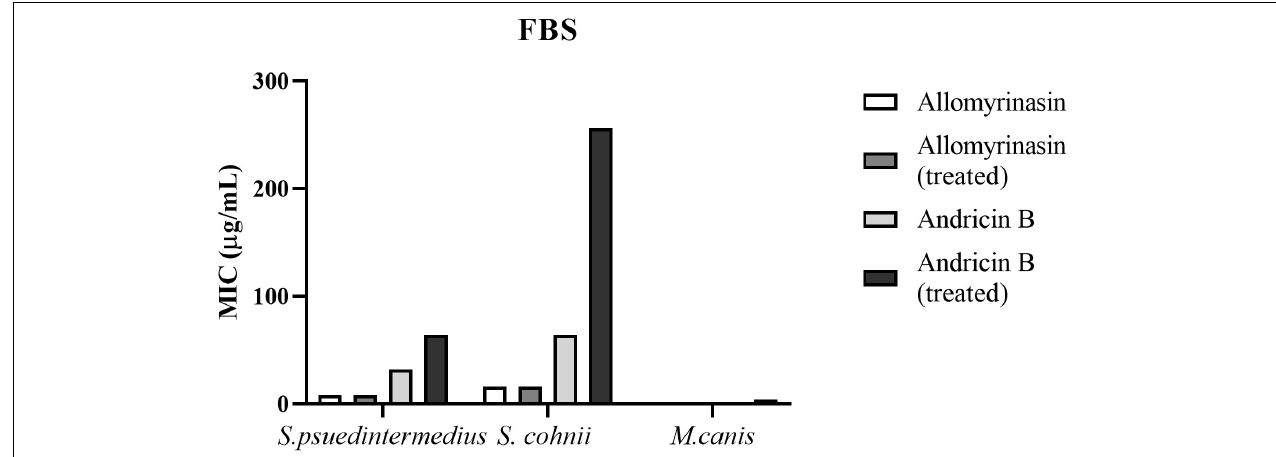
FIGURE 7 | Minimal inhibitory concentrations (MICs) of allomyrinasin and andricin B with or without serum treatment against Staphylococcus pseudintermedius MW767056, Staphylococcus cohnii MW767053, and Microsporum canis MW768151. The experiments are carried out in triplicate from two independent experiments.